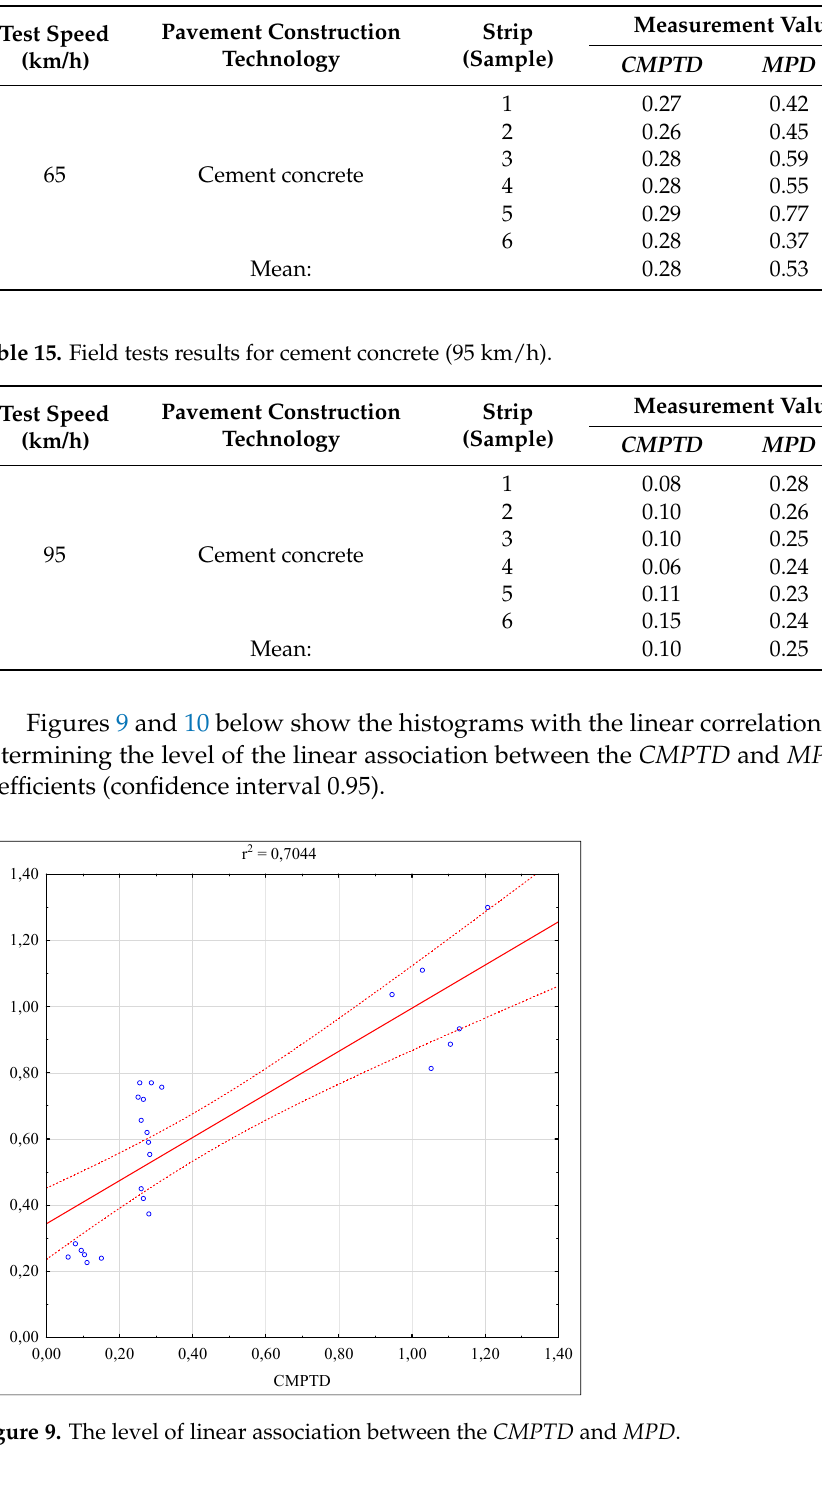
Table 14. Field tests results for cement concrete (65 km/h).